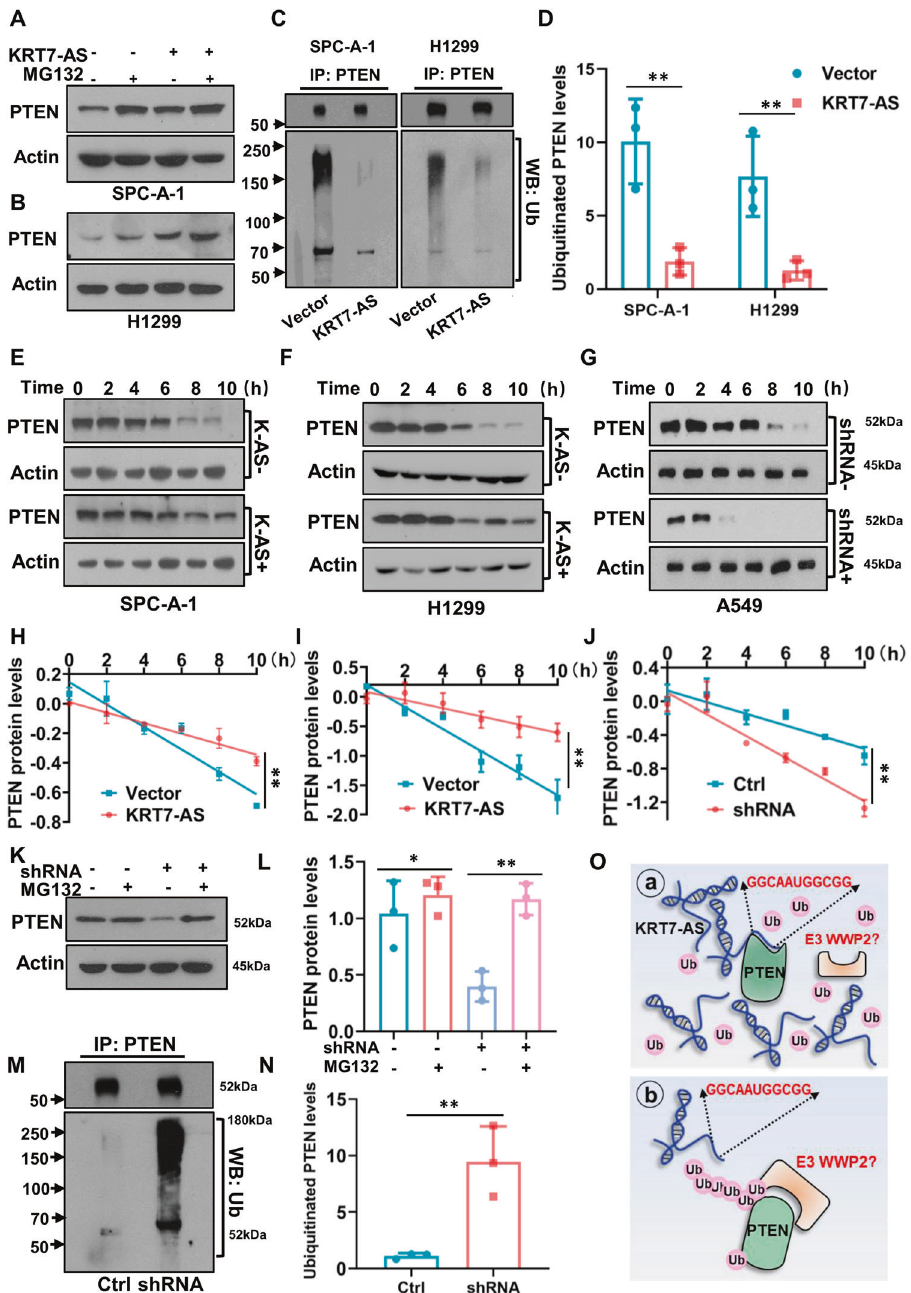
reversed the ubiquitination of PTEN protein in SPC-A-1 and H1299 cells ( C , D ). The half-life of PTEN protein was prolonged by KRT7-AS overexpression in the presence of the protein synthesis inhibitor CHX in SPC-A-1 ( E , H ) and H1299 cells ( F , I ). Silencing of KRT7-AS shortened the half-life of PTEN protein in A549 lung cancer cells ( G , J ). KRT7-AS-mediated degradation of PTEN protein in A549 cells was signi fi cantly reversed by the ubiquitination inhibitor MG132 ( K , L ). Silencing of KRT7-AS signi fi cantly increased ubiquitination of PTEN protein in A549